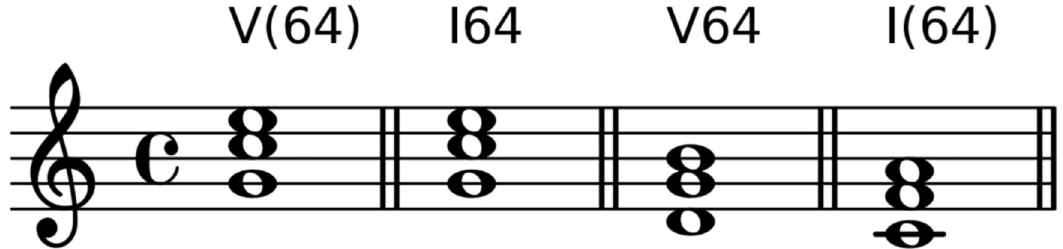
Fig 3. Chord suspensions and inversions. Examples of chord inversions (no brackets) and suspensions (brackets).